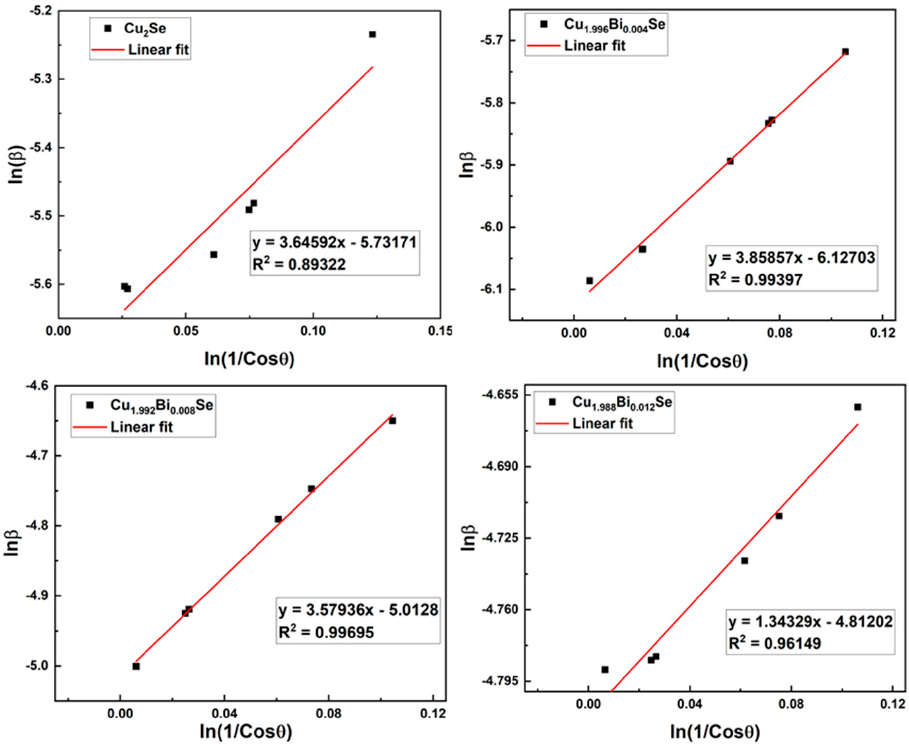
Figure 3. Modified Scherrer plots of Cu 2 − x Bi x Sesamples.